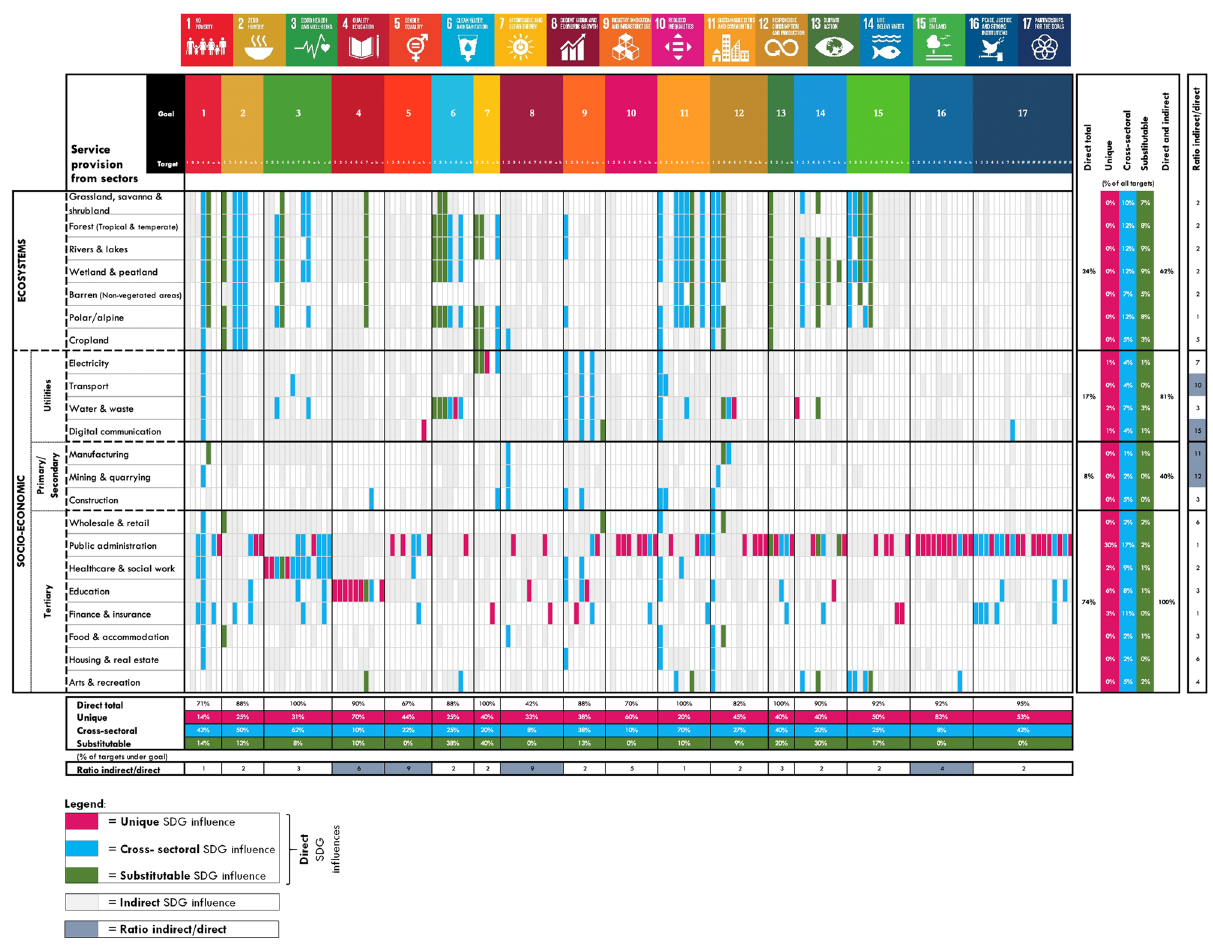
Fig. 3 Ecosystems and socio-economic sectors in fl uence SDG targets. Each rectangle represents one SDG target: magenta shading denotes a unique direct in fl uence; blue a cross-sectoral in fl uence; and green a substitutable in fl uence for achieving the SDG target. Grey indicates an indirect in fl uence, where there is published evidence that improving the quality/quantity of the sector ’ s services can help achieve the SDG target. White shading indicates the absence of identi fi ed evidence. Evidence is reported in Supplementary Data Tab 3.1. Icon images courtesy of United